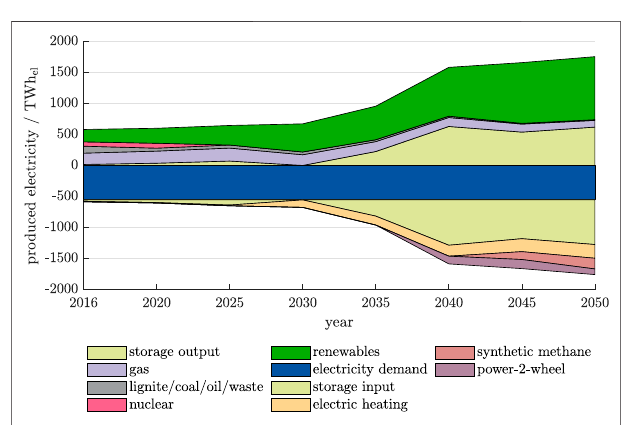
FIGURE 5 | Produced electricity (positive) and consumed electricity in cross-sectoral technologies (negative) in the German energy transition. Gas includes gas turbines as well as combined cycle gas turbines. Power-2-wheel includes battery electric vehicles, fuel cell vehicles, and synthetic diesel.